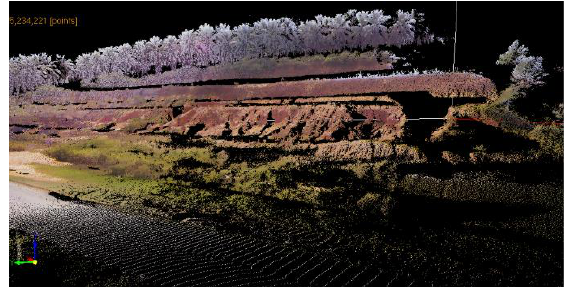
Figure 32. After finished the colour matching from the image